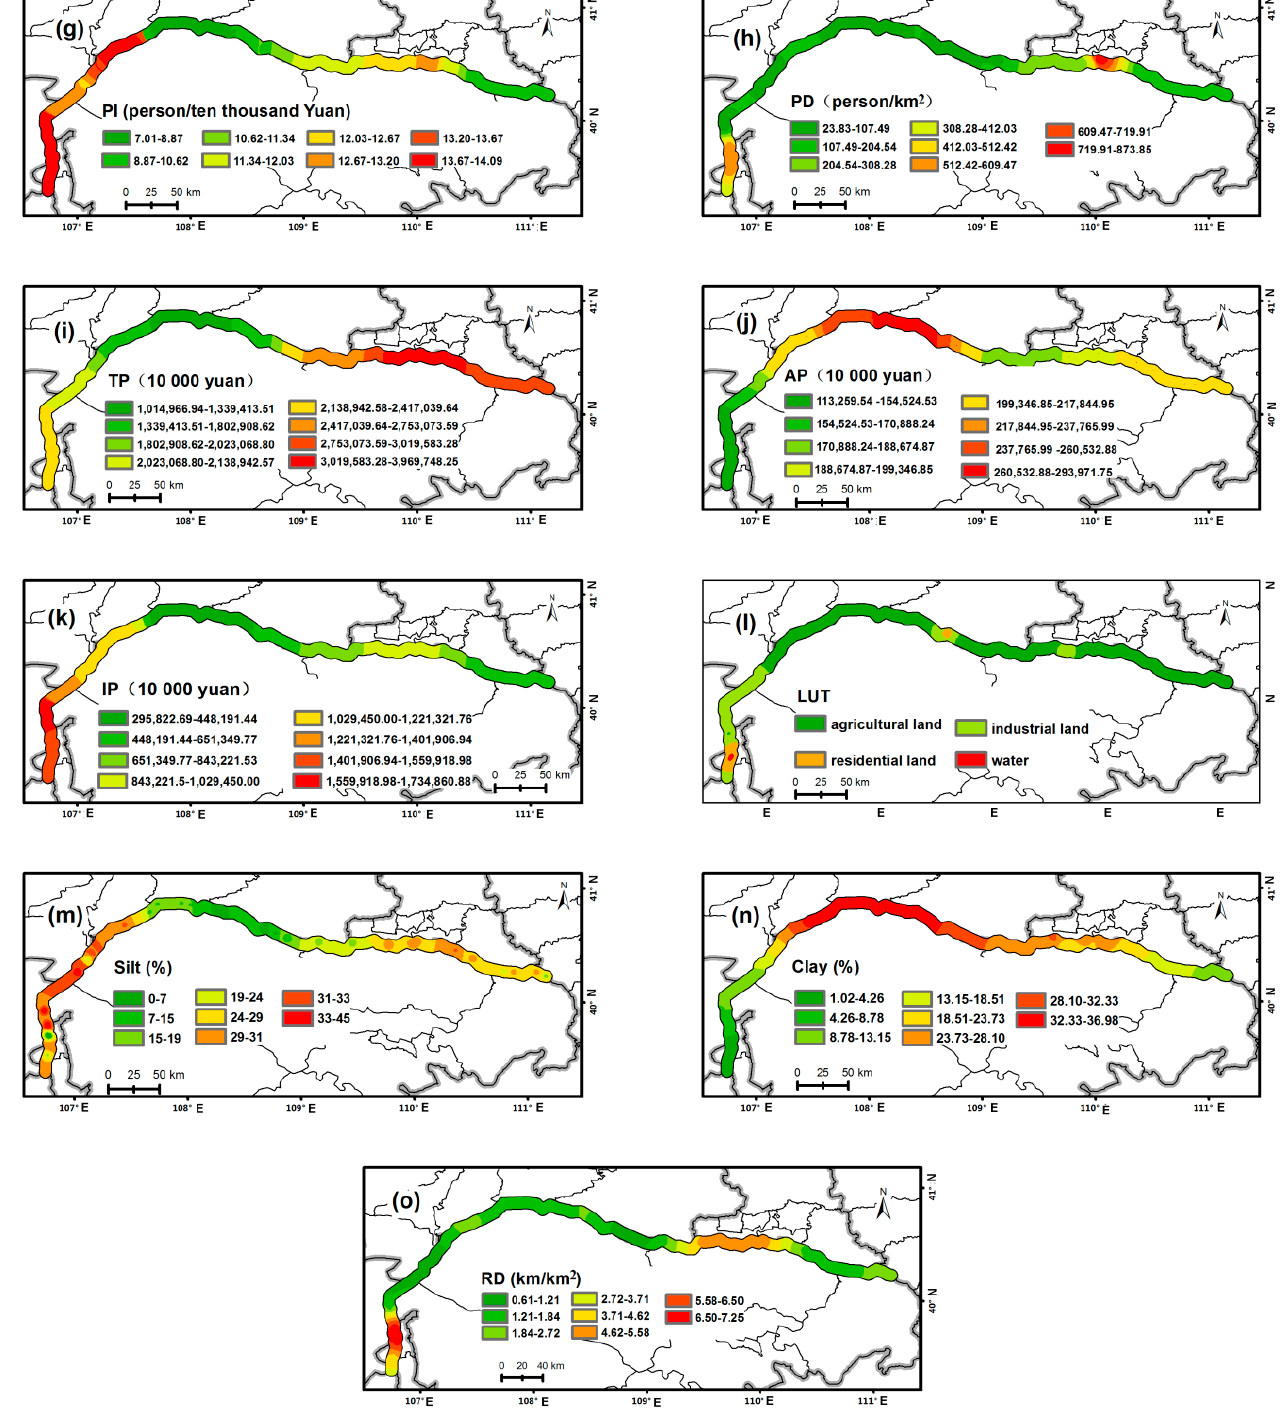
Figure 5. Spatial distribution of heavy metal influencing factor ( a ) pH, ( b ) EC, ( c ) VC, ( d ) TOC, ( e ) DEM, ( f ) ST, ( g ) PI, ( h ) PD, ( i ) TP, ( j ) AP, ( k ) IP, ( l ) LUT, ( m ) Silt, ( n ) Clay, and ( o ) RD in sediment of Inner Mongolia section of Yellow River.